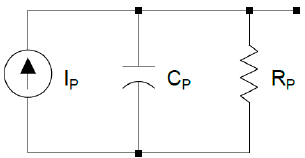
Figure 14. Pyroelectric harvester equivalent circuit.